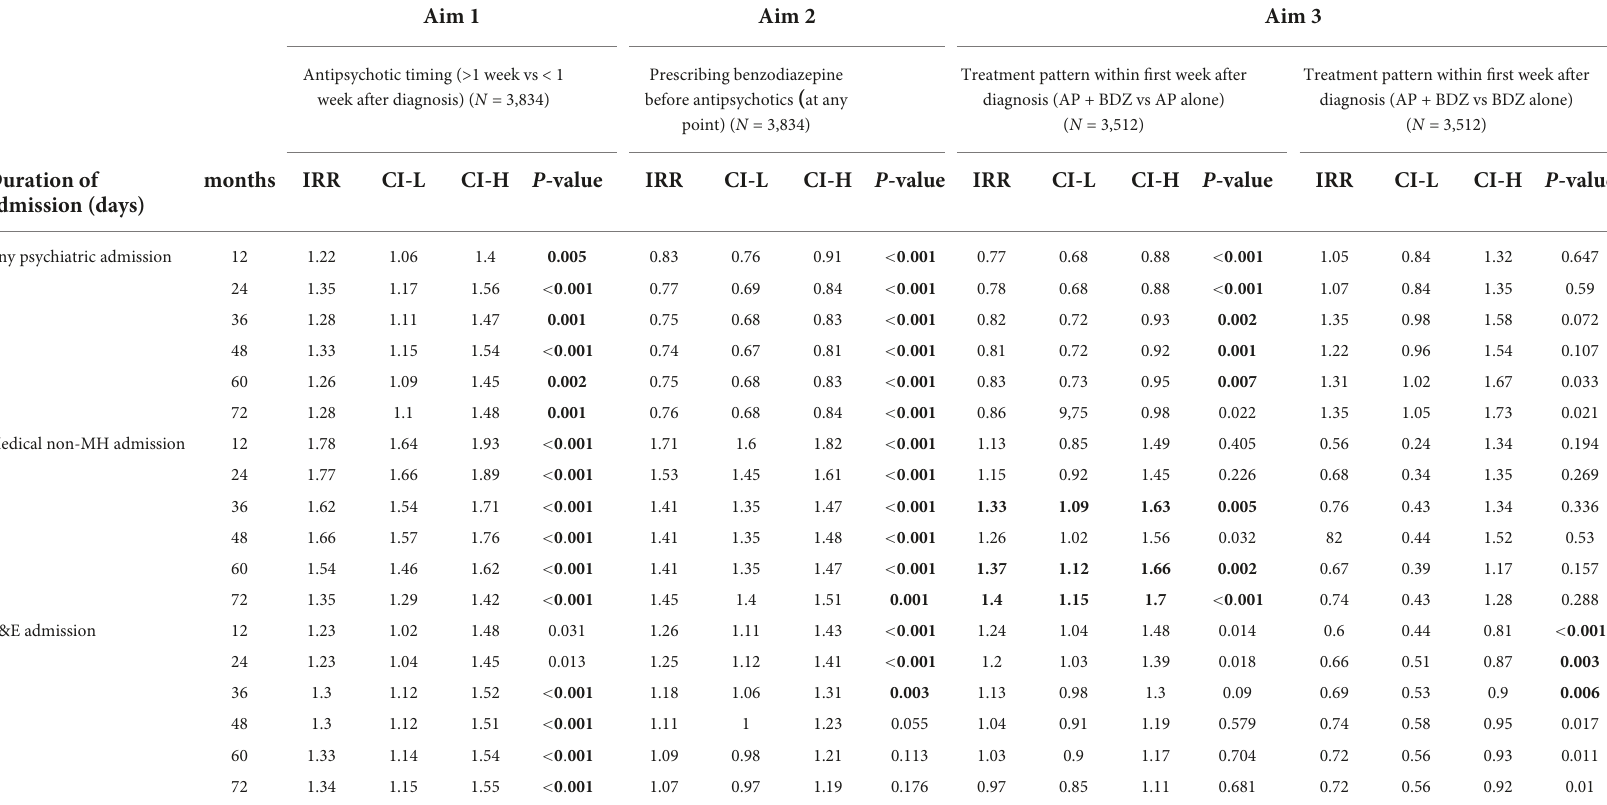
TABLE 3 Zero-inflation negative binomial regressions to assess the effect of exposure variables (antipsychotic timing, prescribing benzodiazepine before antipsychotics at any point and treatment patterns within first week after diagnosis) on secondary outcomes, adjusted for age, sex, severity, and